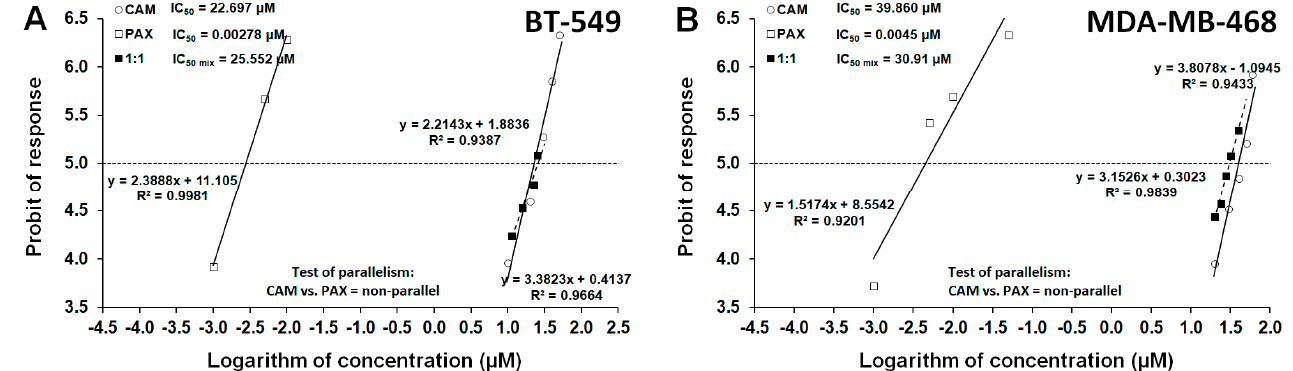
Figure 3. Log-probit concentration-effect relationship curves (CECs) for PAX and CAM used singly and in combination at the fixed-ratio of 1:1 for ( A ) BT-549 and ( B ) MDA-MB-468 TNBC cells. Concentrations of CAM and PAX were transformed into logarithms and the anti-proliferative effects into probits. The dotted line (parallel to the abscissa at 5th probit) indicates in approx. the IC 50 values for PAX and CAM. Test of parallelism between PAX and CAM indicated that both lines are not collateral to each other.